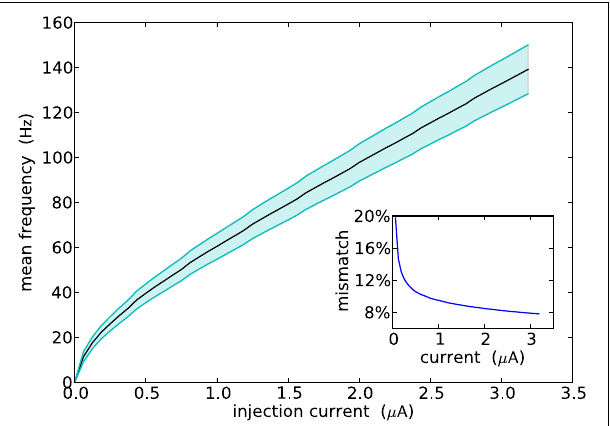
FIGURE 5 | Population response of all neurons in the array to constant injection currents. The variance in the measurements is due to device mismatch effects in the analog circuits.